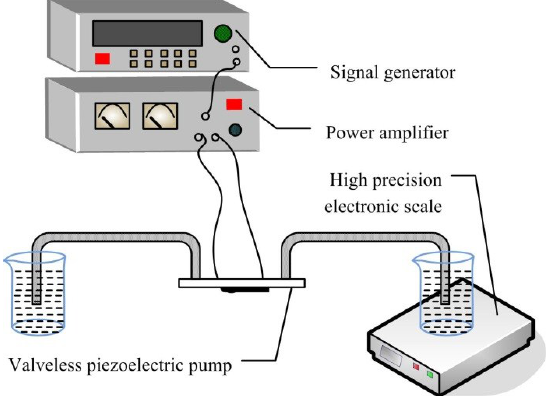
Figure 2. Schematic diagram of the flow experiments.